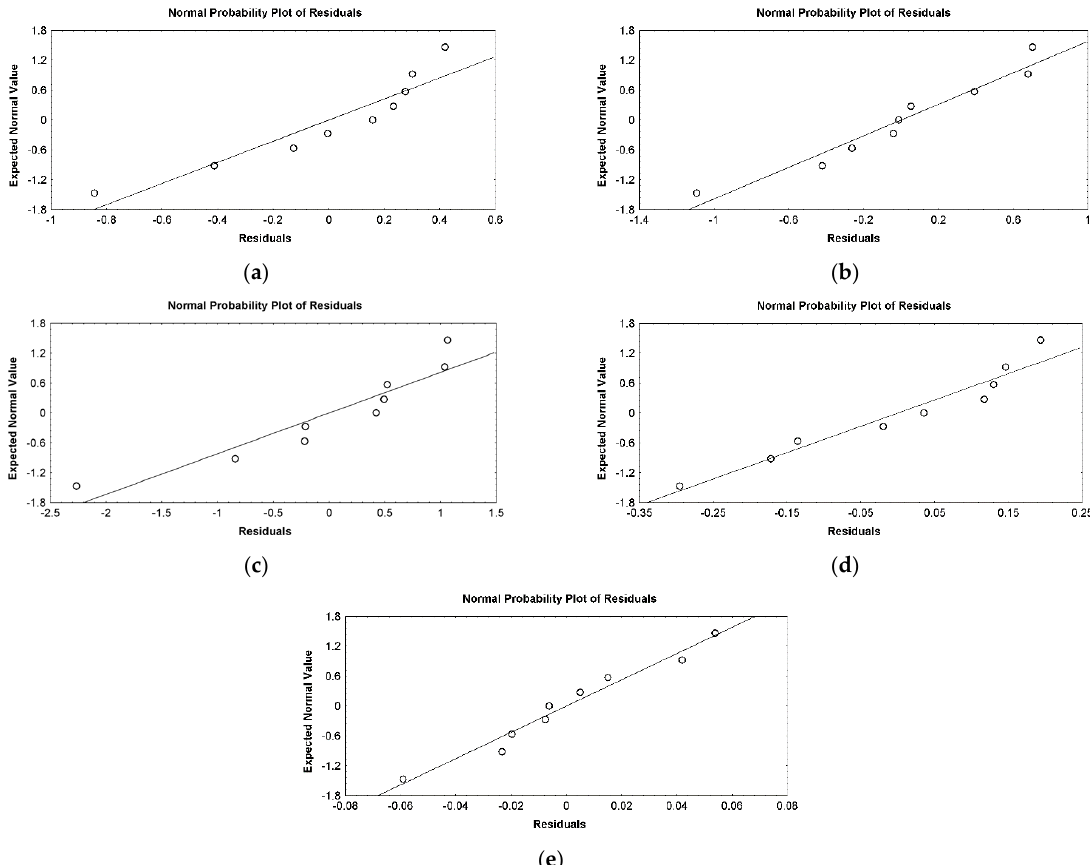
Figure 4. Plot showing correlation between the expected normal values and residuals for ( a ) WCW (g/L), ( b ) DCW (g), ( c ) CA (°), ( d ) PC (%), and ( e ) DS (%).